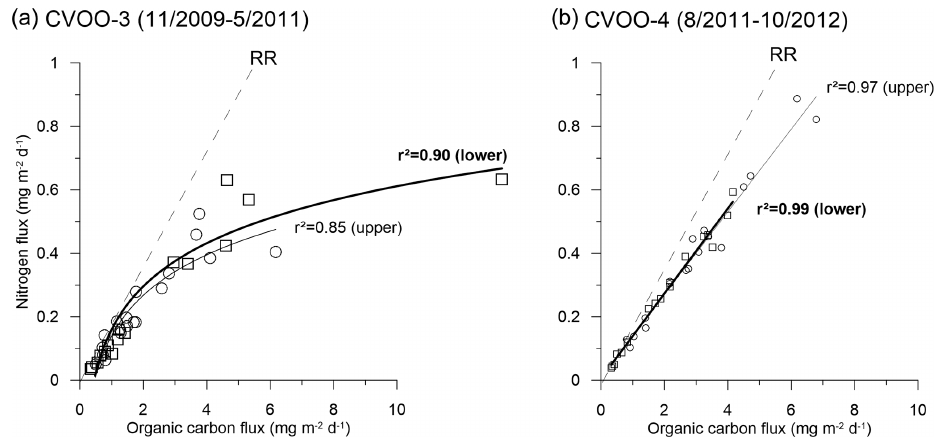
Figure 10. Different C : N flux relationships (best fits) during the 2010 and 2012 ACME passages during fall–winter (2011 oligotrophic fluxes are included in a ); RR is the Redfield ratio (Redfield et al., 1963). Note the non-linear changes during the extreme 2010 ACME (a) , pointing to nitrogen limitation, and, for comparison, the linear relationship later in 2012 (b)